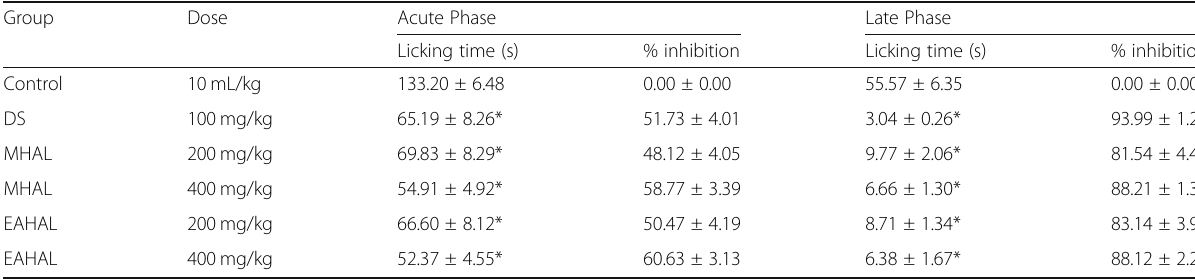
Numbers of licking time inhibition are presented as (mean±standard error of mean). MHAL=Methanol extract of Hemigraphis alternata leaves. EAHAL=Ethyl acetate extract of Hemigraphis alternata leaves. “ * <0.05, 0.01, 0.001 versus control group (Dunnett ’ s test)